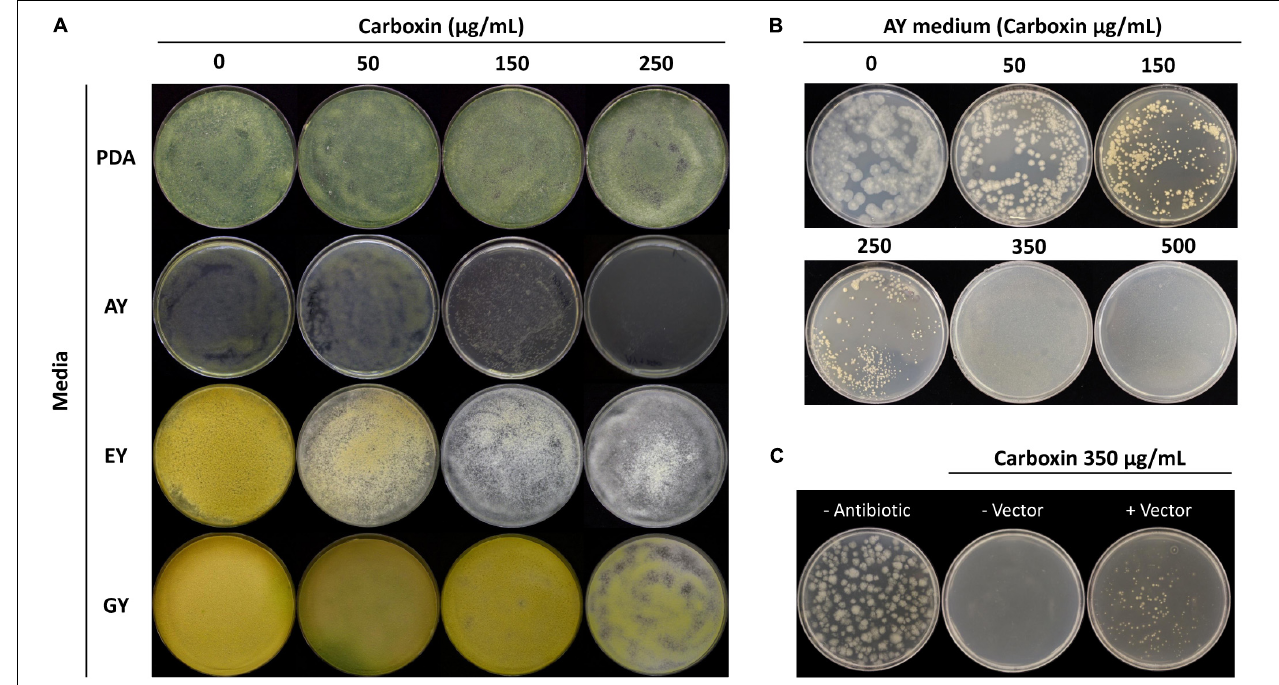
FIGURE 6 | Trichoderma virens carboxin resistance. (A) Carboxin effect for mycelial growth of T. virens on different media [potato dextrose agar (PDA), acetate-acetic/yeast extract medium (AY), ethanol/yeast extract medium (EY) and glucose/yeast extract medium (GY)] containing various concentrations of carboxin. The wild-type (WT) strain was cultured for 7 days. (B) Carboxin sensitivity in T. virens WT on AY medium after 14 d.p.i. (C) Selection of carboxin resistance transformants of T. virens . Protoplasts were transformed with linearized pTrichoGate-19 vector, and then cultured on AY medium containing carboxin 350 µ g/mL after 7